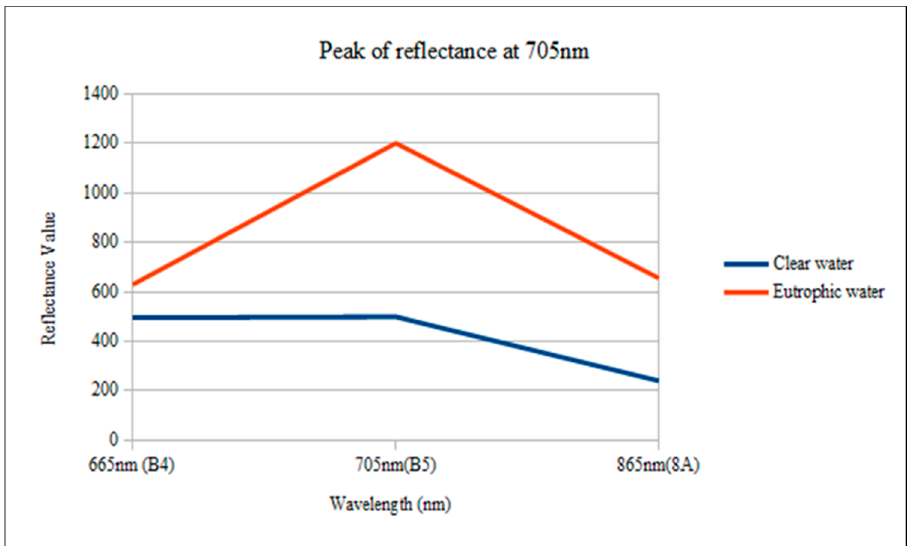
Figure 2. Peak of the reflectance in eutrophic waters at 705 nm of the electromagnetic spectrum, based on Sentinel-2 Multispectral Imager (MSI) bands.